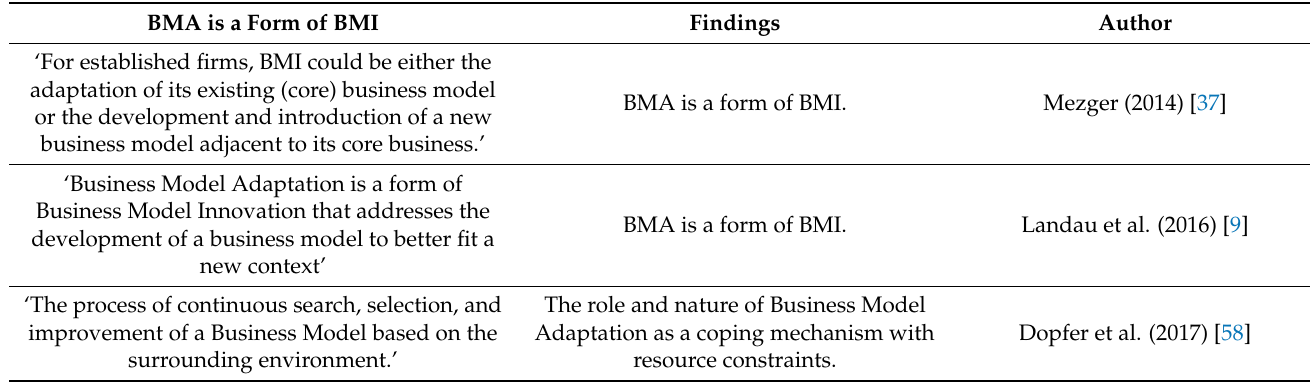
Table 6. BMA is a form of